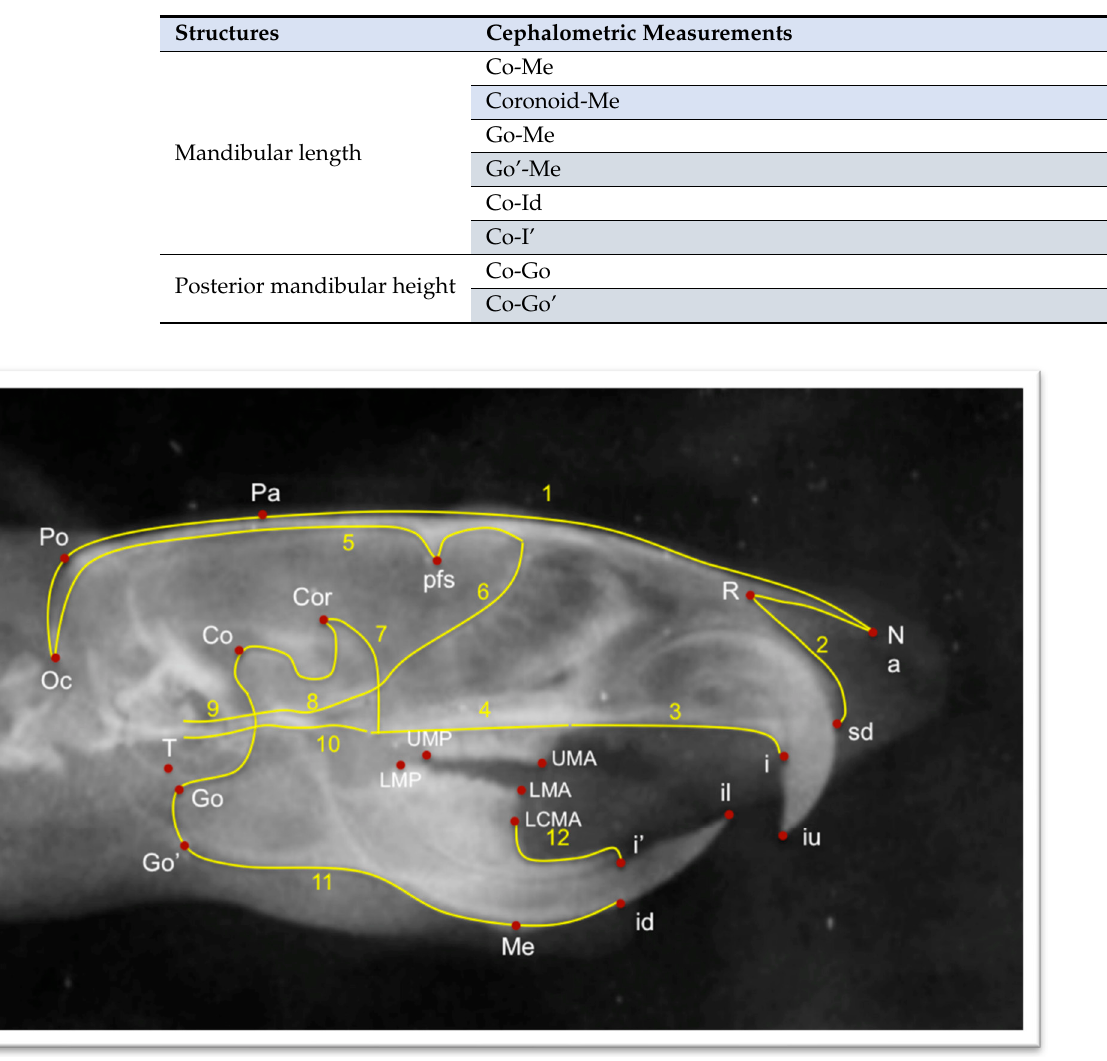
Table 3. Cephalometric measurements.